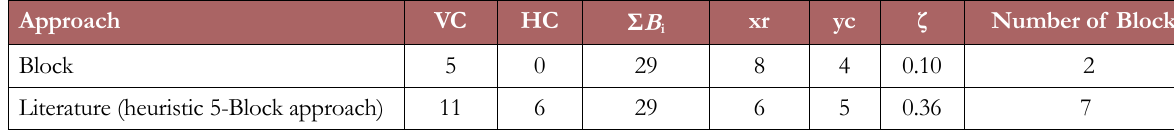
Figure 5. Layouts of Instance 4